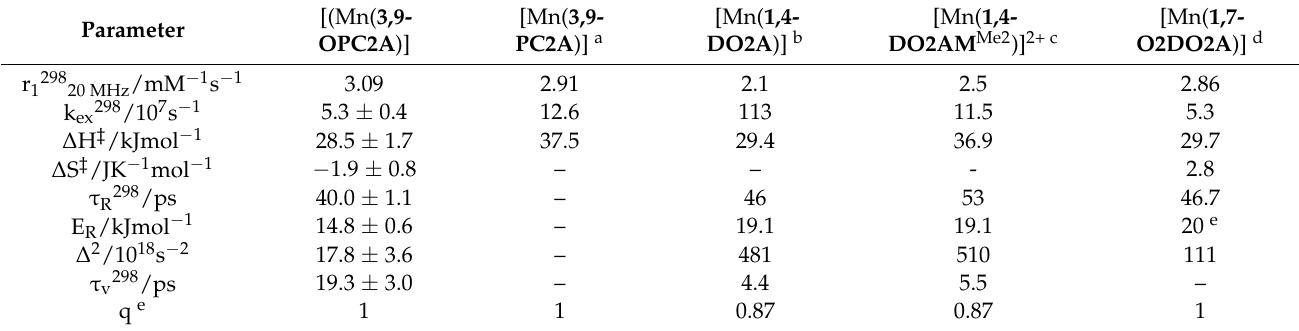
and the activation energy of the modulation of the zero-field-splitting, E v to 1.0 kJmol − 1 . Table 5. Relaxivity and best-fit parameters obtained from the analysis of 17 O NMR and NMRD data for the (Mn( 3,9-OPC2A )) complex, compared with the corresponding values of [Mn( 3,9-PC2A )], [Mn( 1,4-DO2A )], Mn( 1,4-DO2AM Me2 ] 2+ , and [Mn( 1,7-O2DO2A )].